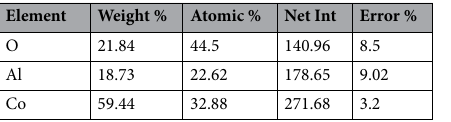
Table 1. EDX Analysis for The Parent Nano CoAl 2 O 4